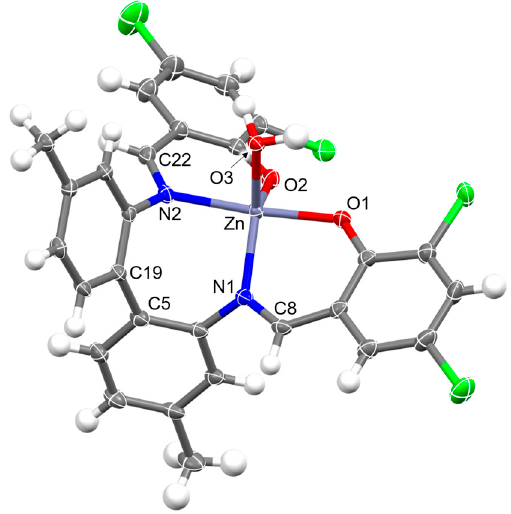
Figure 2. Molecular structure of Z1Zn determined by X-ray diffraction at 100 K. The ellipsoids are drawn with a 50% probability. White: H, gray: C, blue: N, red: O, light green: Cl, and blue-gray: Zn.